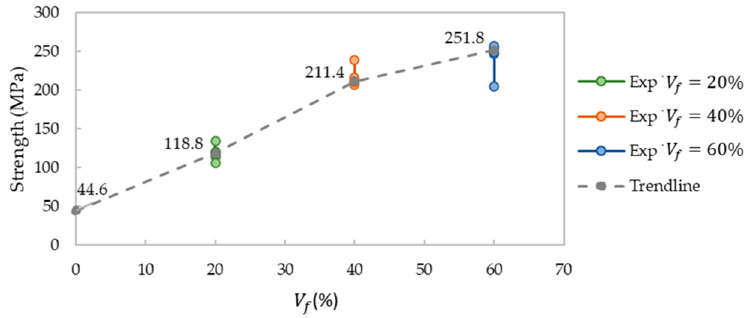
Figure 8. Effective tensile strength of SFRC in axial load, depending on volume fraction.